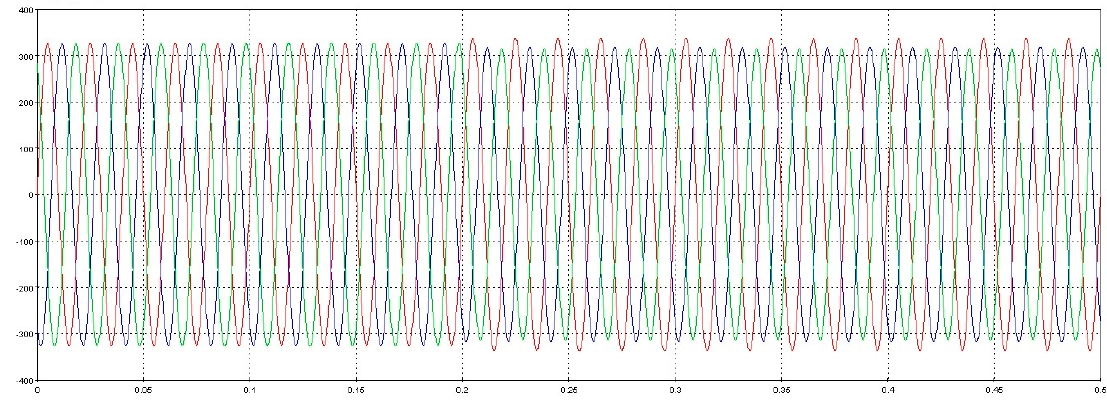
Figure 15. Output voltage waveform under droop control.